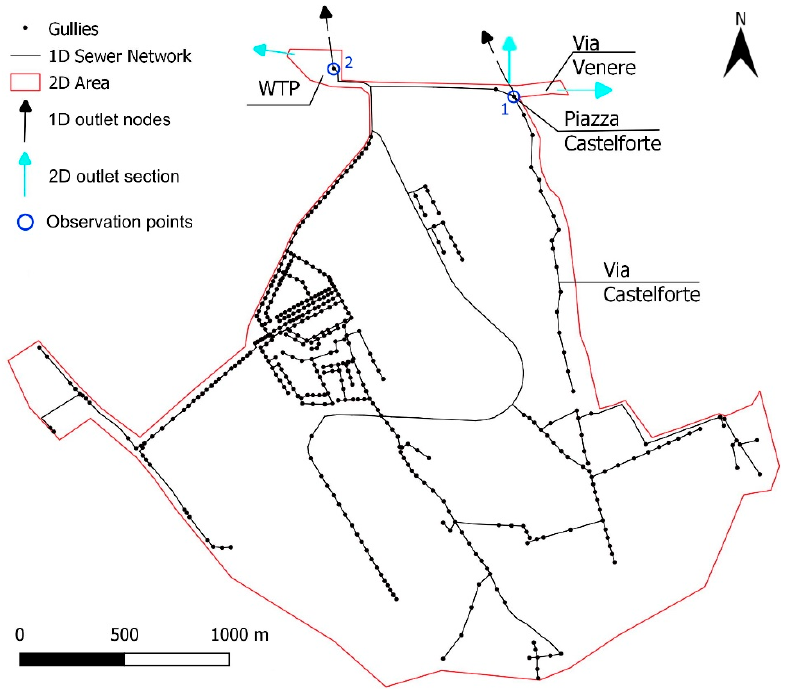
Figure 4. 1D sewer network (black lines) and gullies (black points).